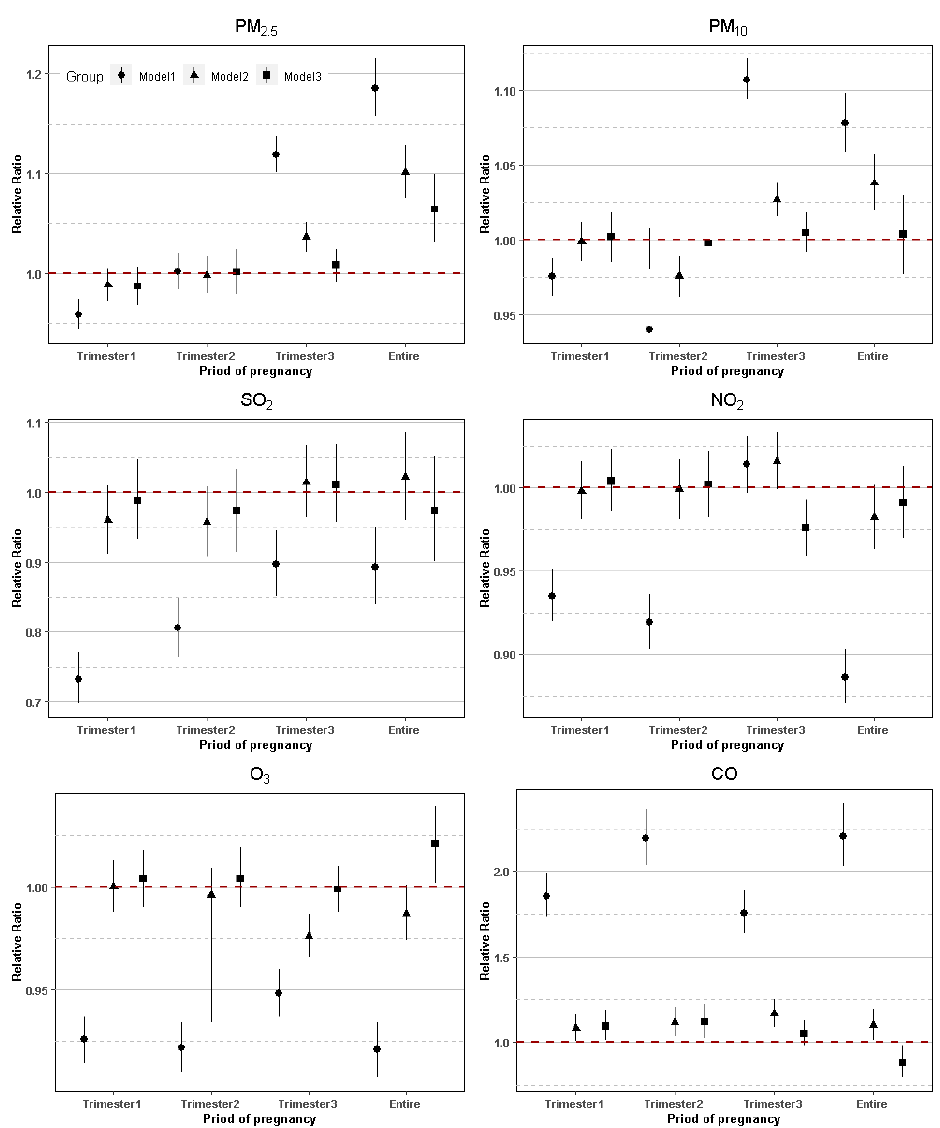
Figure 3. Adjusted RRs (95% CIs) for PTB associated with air pollutants during the different stages of pregnancy in Model 1 – 3. Note: Model 1: single-pollutant model, adjusted for covariates including mean temperature and humidity, which was represented by a circle; Model 2: single-pollutant model, adjusted for covariates including mean temperature and humidity, age of mother and father, and weight of birth, which was represented by a triangle; Model 3: multi-pollutant model, adjusted for covariates including mean temperature and humidity, age of mother and father, weight of birth, and additionally adjusted for other air pollutants, which was represented by a square.